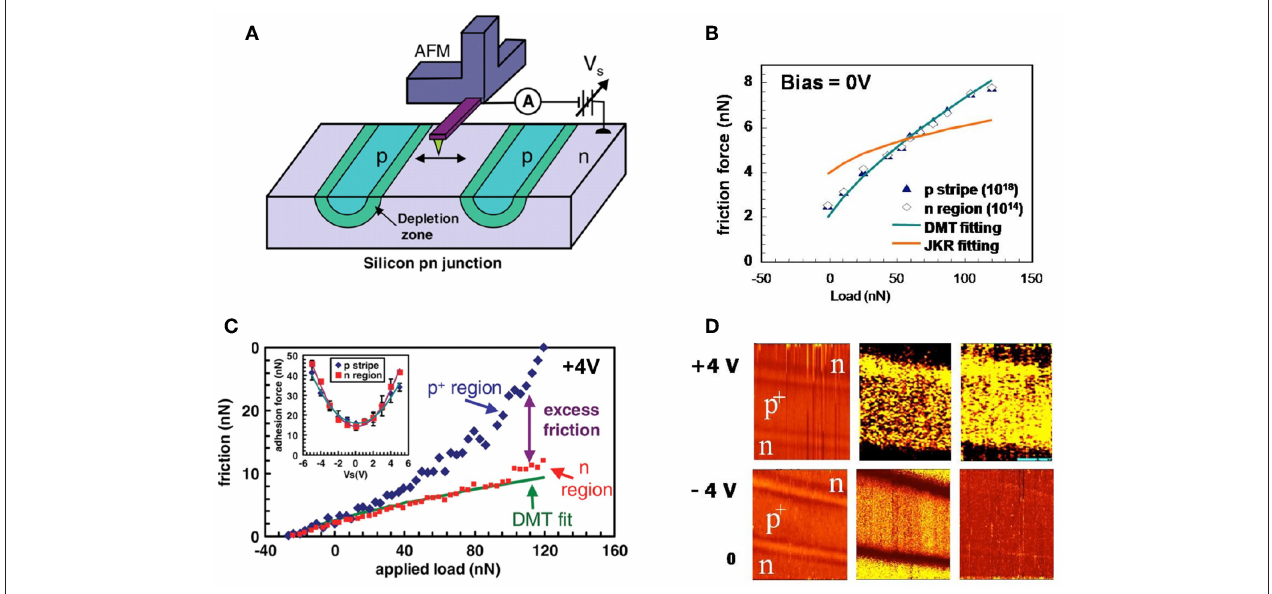
FIGURE 3 | (A) Schematic of AFM measurements on a silicon pn junction device. (B) In the absence of an external bias voltage the friction force vs. load curve for p-type and n-type regions of the surface are indistinguishable. Application of positive (C) or negative (C,D) bias voltages allows the friction to be tuned. The excess friction in the presence of an external bias is attributed to static charge and triboelectric effects. Reprinted with permission from Park et al. (2006) (A,C) ; and Park et al.